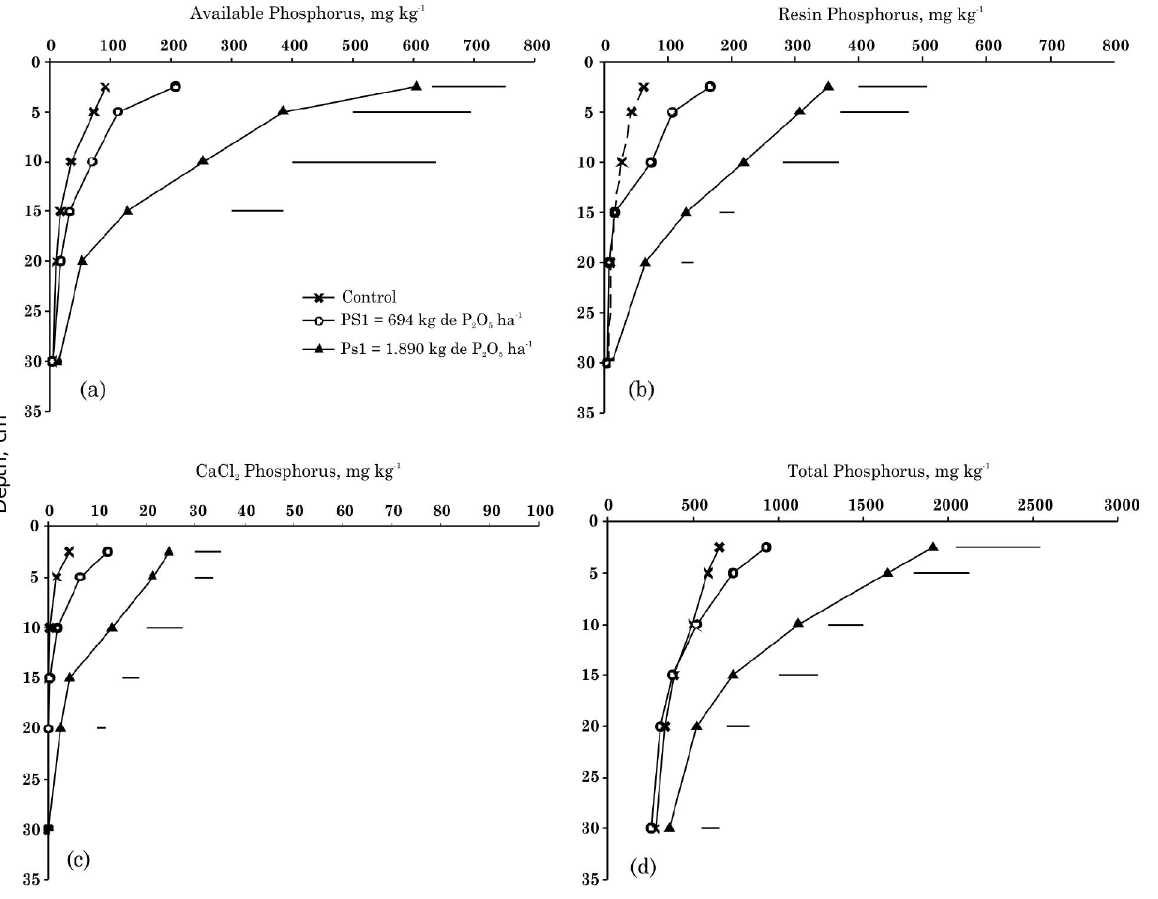
Figure 1. Phosphorus extracted by Mehlich 1 (a), anion exchange resin (b), 0.01 mol L -1 CaCl 2 (c) and total P (d) throughout the profile of a Typic Hapludult soil without the pig litter fertlization, with the application of pig slurry (PS1) and of pig manure (PM1) in a no-till system. The horizontal bars indicate minimum significant difference by the Tukey test at 5